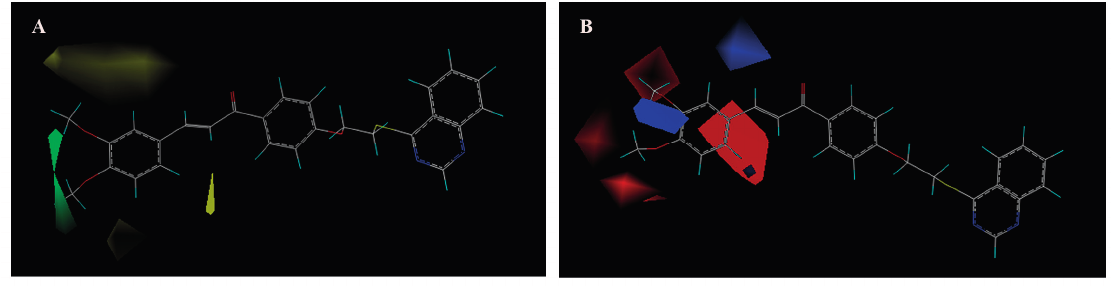
Figure 2. CoMFA contour map for the steric ( A ) and electrostatic ( B )